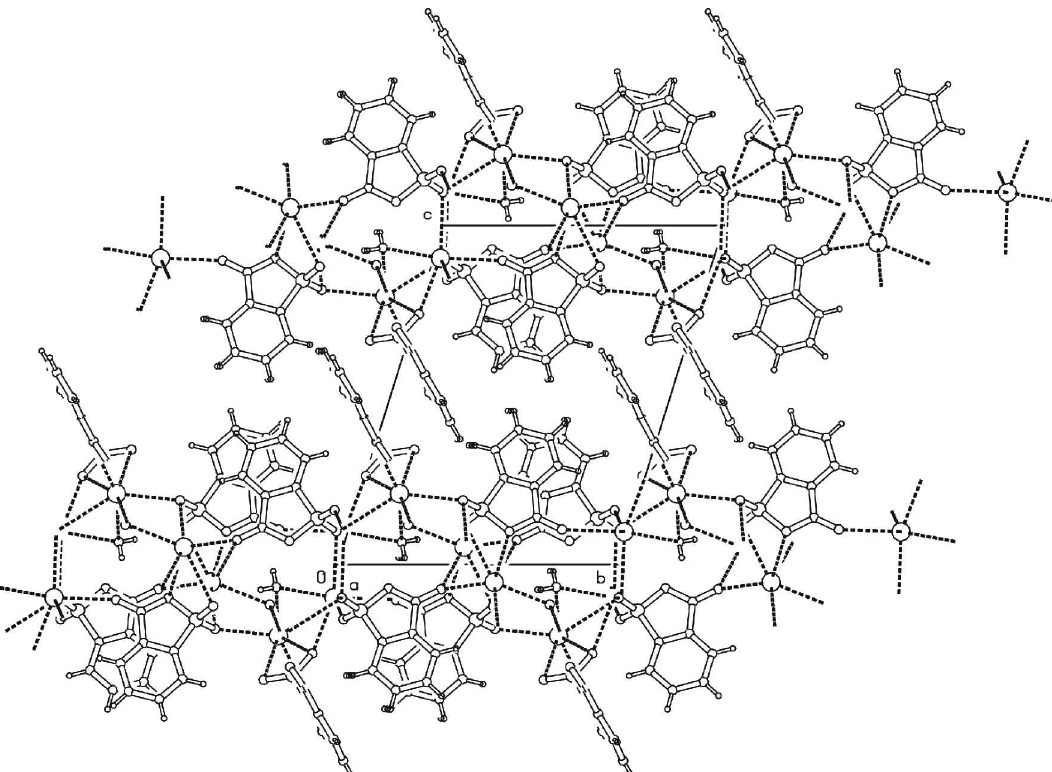
Fig. 2 The Crystal structure packing in K 3 (sac) 3 ¢ 2H 2